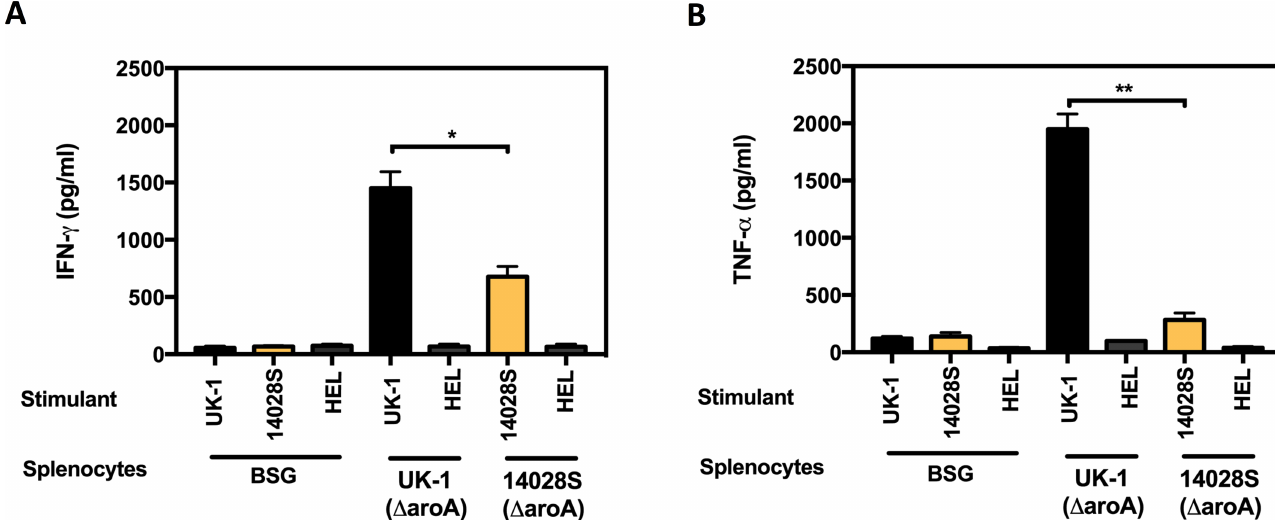
Fig 3. APC-mediated T-cell activation and cytokine secretion. T-lymphocytes obtained from BALB/c mice ( n = 5) orally immunized with UK-1( Δ aroA ), 14028S( Δ aroA ) or BSG (mock) were co-incubated with respective UV-inactivated UK-1 or 14028S-infected and mitomycin C—treated APCs. APCs treated with an unrelated antigen, HEL, were also included for comparison. The co-cultures were incubated for 72 h and supernatants were collected for determination of (A) IFN- γ , (B) TNF- α . (cid:3) P (cid:20) 0.05, (cid:3)(cid:3) P (cid:20) 0.01.